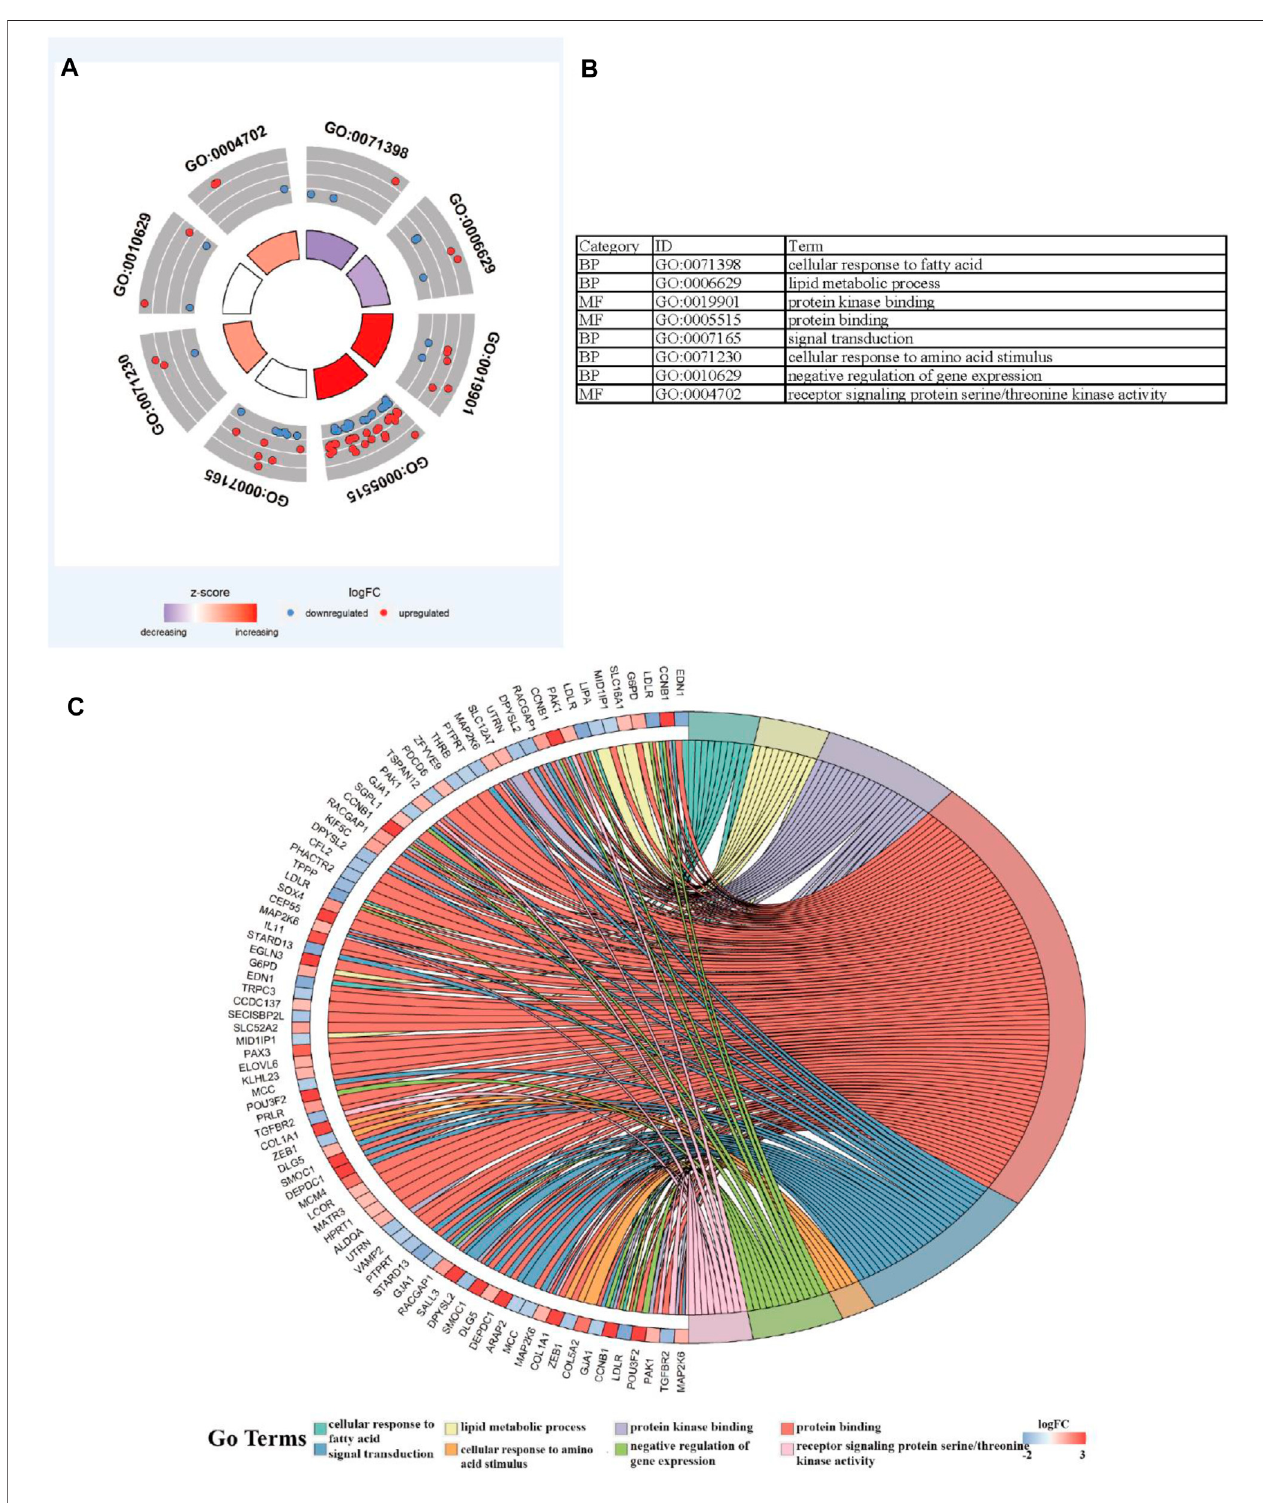
FIGURE 5 | Functional enrichment analysis. (A – C) GO analysis indicating top eight GO terms for which differentially expressed mRNAs were most enriched.